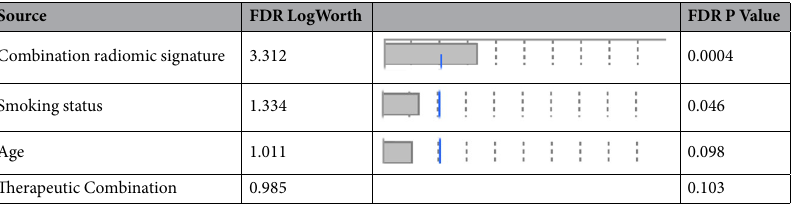
Table 4. Effect summary in the light of False Discovery Rate (FDR)